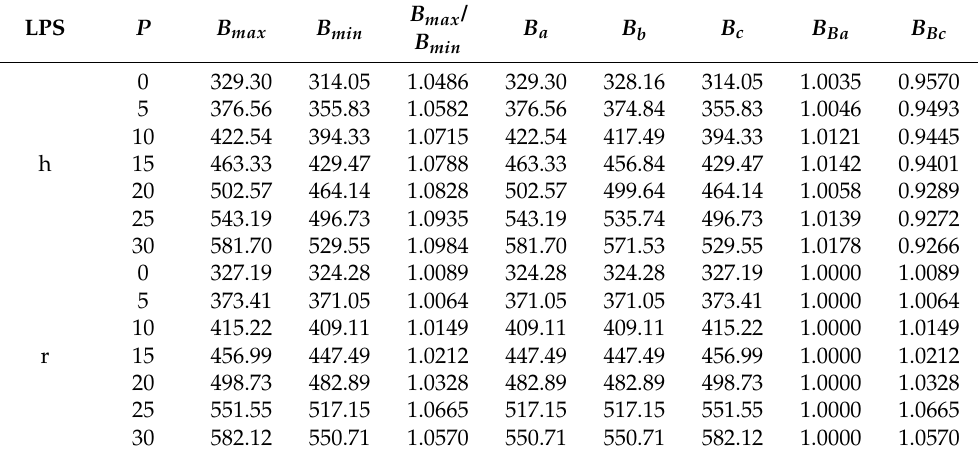
Table 5. Calculated external ( B max , B min ) and linear ( B a , B b , B c ) bulk moduli (in GPa) and relative ratios ( B max / B min , B Ba , B Bc ) for the LPSs h- and r-Al 2 Ti under pressure up to 30 GPa at 0